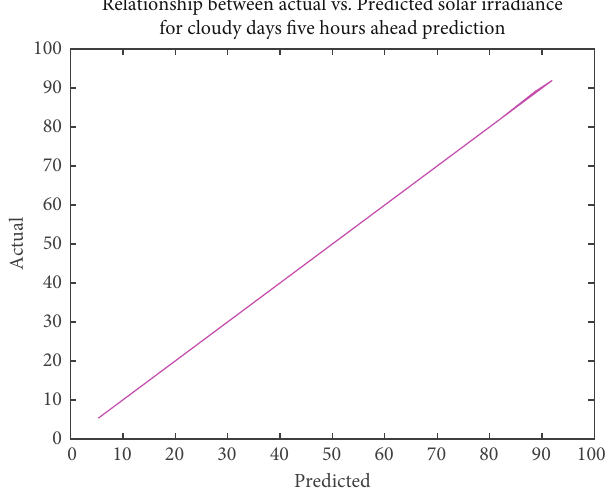
Figure 36: Relationship between actual vs. predicted solar irradiance for cloudy day fi ve-hour-ahead prediction.